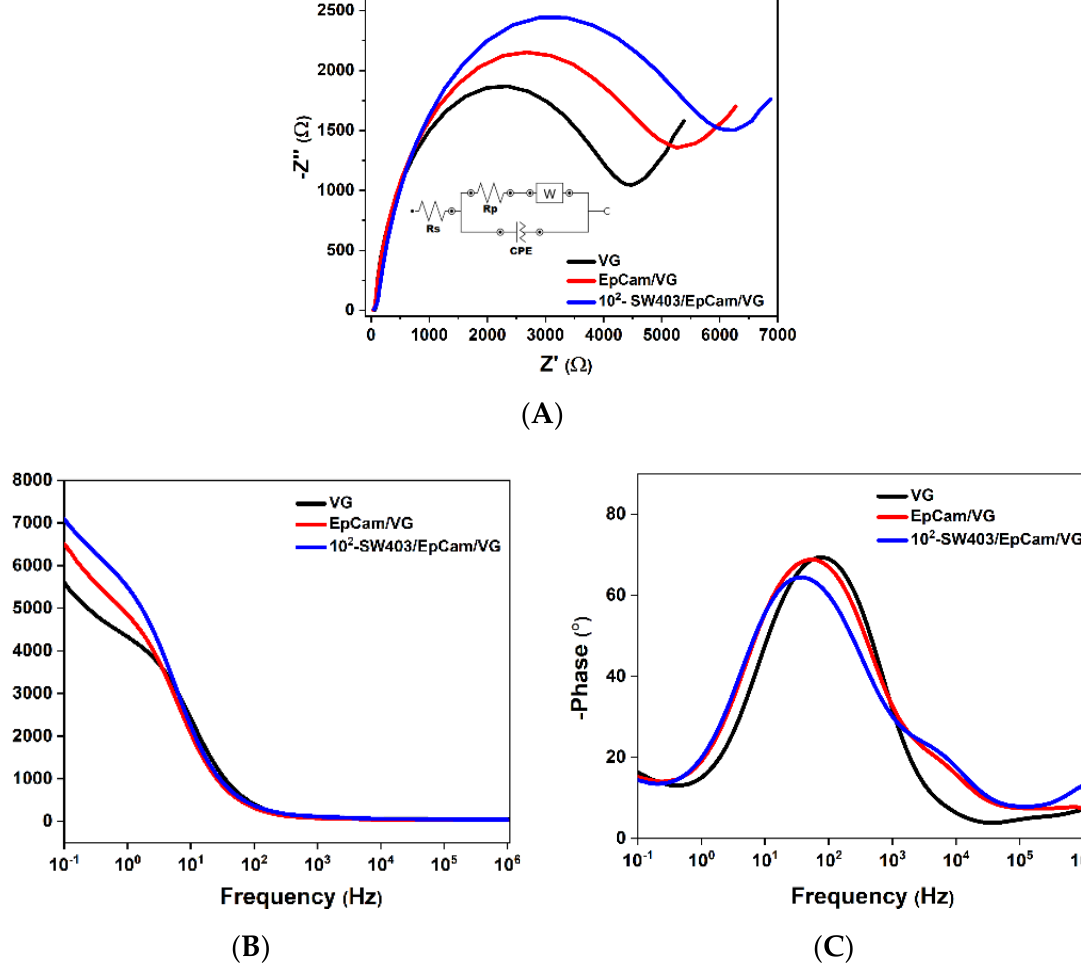
Figure 7. ( A ) Nyquist diagram; ( B , C ) Bode diagrams of VG: sensor blank, EpCam/VG-based sensor and sensor after capturing 100 cell mL −1 concentration of SW403 cells from 0.1 to 10 6 Hz in PBS solution containing 1 mM [Fe (CN)6] 3−/4− and 0.1 M KCl. The impedance spectra (Nyquist plots) of the blank sensor (black curve), EpCAM/VG- based biosensor (red curve) and sensor after capturing HT-29 cells (blue curve) are shown in Figure 8A. When HT-29 cells are captured on the electrode surface, the charge-transfer pro- cess between the EpCam/VG electrode and the electrolyte solution is disturbed, resulting in the charge-transfer resistance